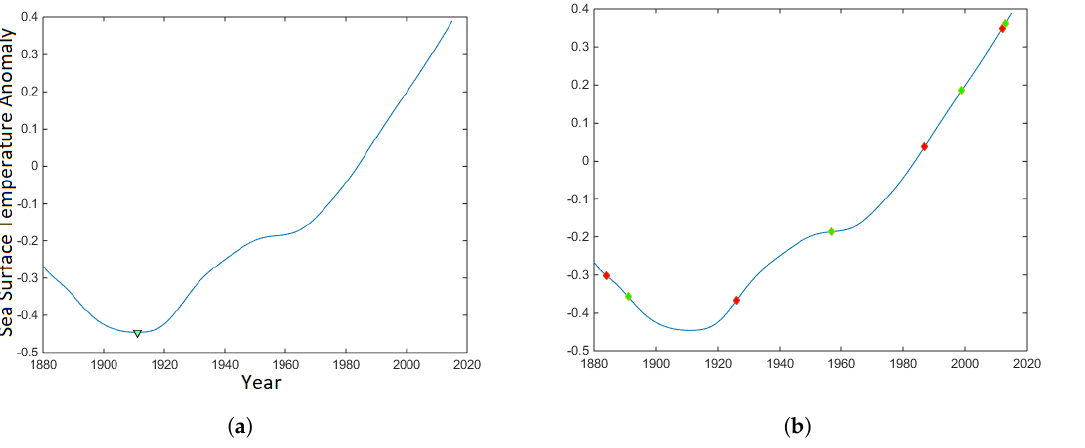
Figure 3. Sea Surface Temperature: ( a ) Detected peaks in the Sea Surface Temperature anomalies (Y axis) between 1880 and 2017 (X axis); ( b ) Identified inflection points in the Sea Surface Temperature anomalies (Y axis) between 1880 and 2017 (X axis). Positive inflection point (red diamond); negative inflection point (green